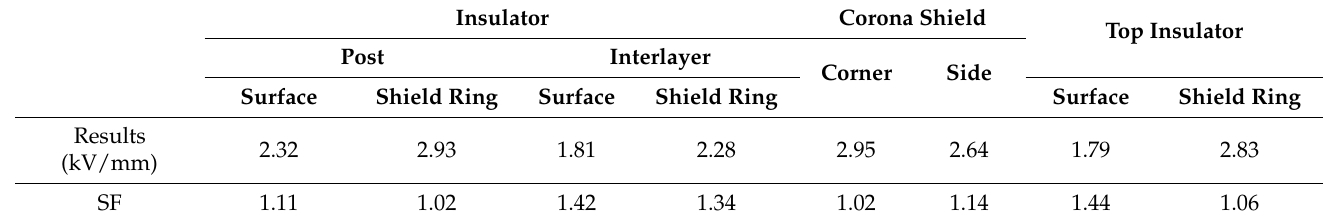
Table 8. Electrical characteristics of the final